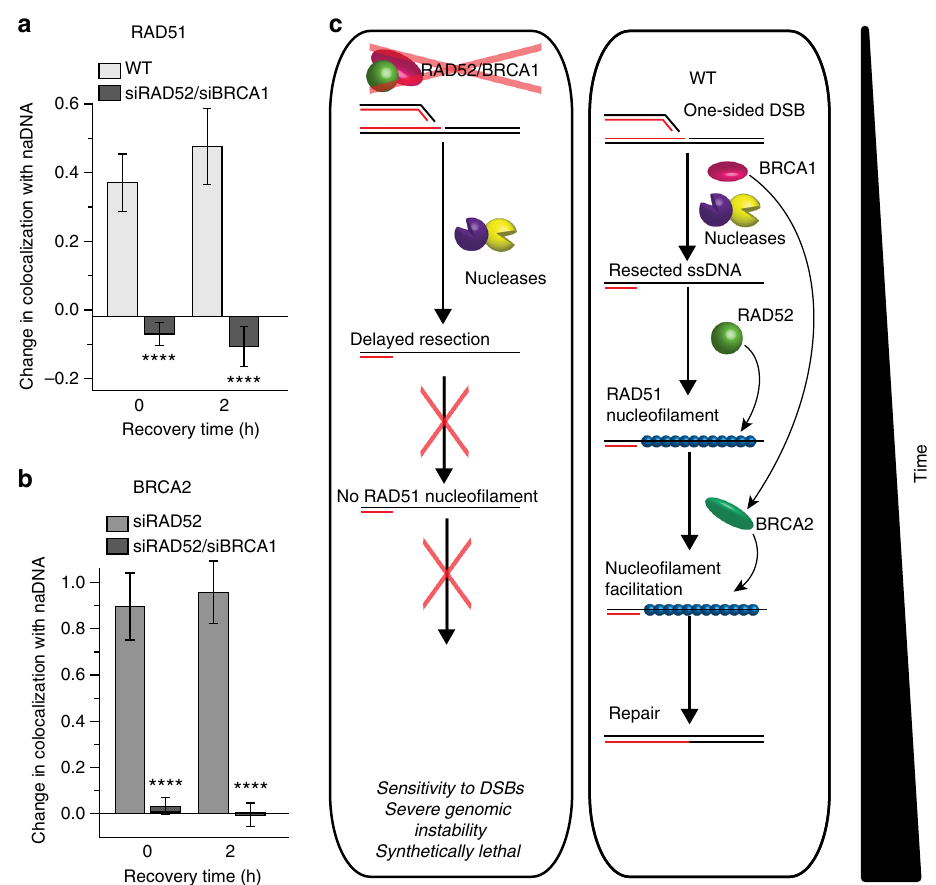
Fig. 7 In the absence of both RAD52 and BRCA2, ssDNA/RAD51 interactions are severely abrogated. a Quanti fi cation of RAD51 association with repair foci following CPT treatment and release (0, 2 h) in BRCA1/RAD52-depleted cells. b Quanti fi cation of BRCA2 association with repair foci following CPT treatment and release (0, 2 h) in RAD52- and BRCA1/RAD52-depleted cells (RAD52-depleted cells shown to contrast increased BRCA2 levels required for ssDNA/RAD51 interactions). c Representations of the HR repair pathway de fi ciency in RAD52/BRCA1-depleted cells and the concluded HR repair pathway in vivo in WT cells. For complete N values, see Supplementary Table 1. Error bars represent mean ± s.e.m. Student ’ s t test for signi fi cance between WT + CPT and siRAD52/siBRCA1 + CPT and siRAD52 + CPT and siRAD52/siBRCA1 + CPT as indicated. **** p <